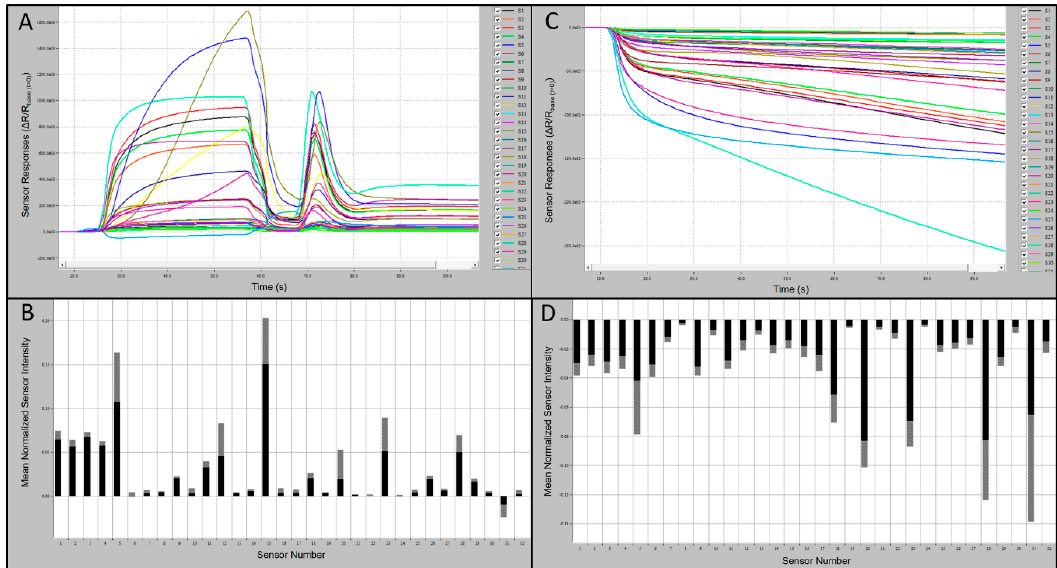
Figure 2. Portable C-320 e-nose output runs and associated smellprint signatures. ( A ) Analysis run